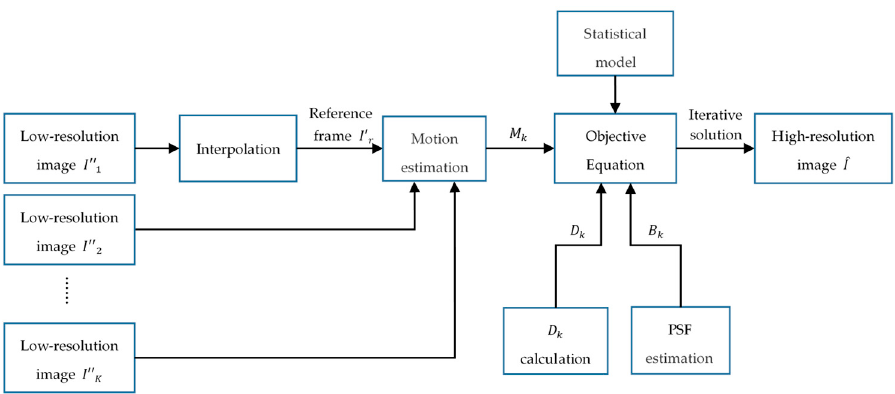
Figure 1. The flow-process diagram of maximum a posteriori (MAP).